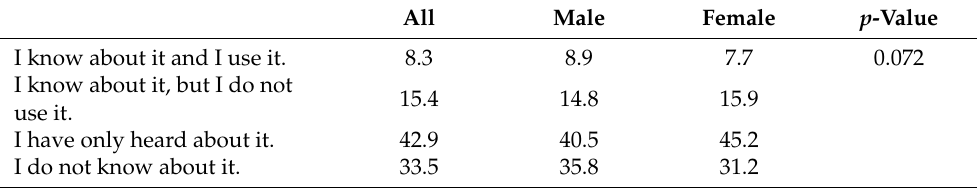
Table 10. Perception and utilization of the dietary reference intakes for Japanese people. All